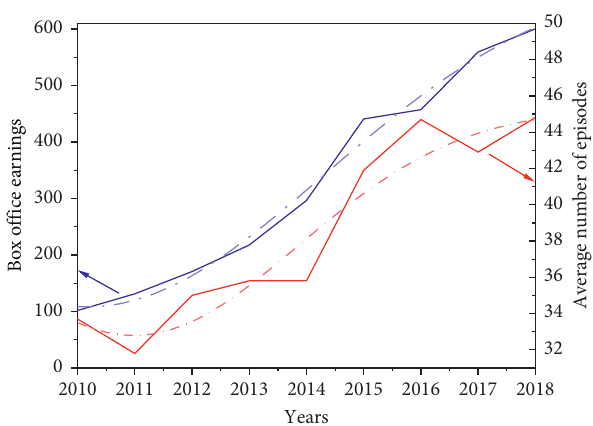
Figure 11: The trends of box office earning and average number of episodes with time.